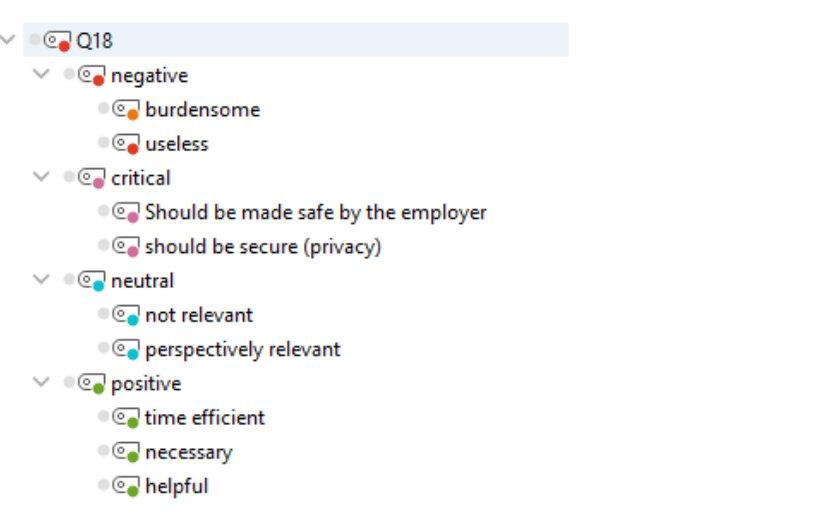
Table 4. Example segments with assigned codes (Q18) “How do you evaluate the use of communi- cation apps in everyday hospital life? ” .